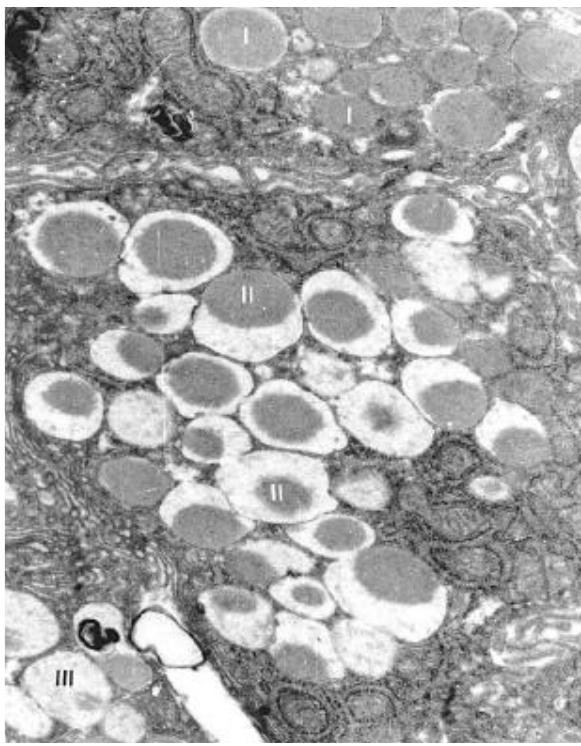
FIGURE 3- Acinus exhibiting cells with differents seromucous-like granules (I, II and III in the figure). x